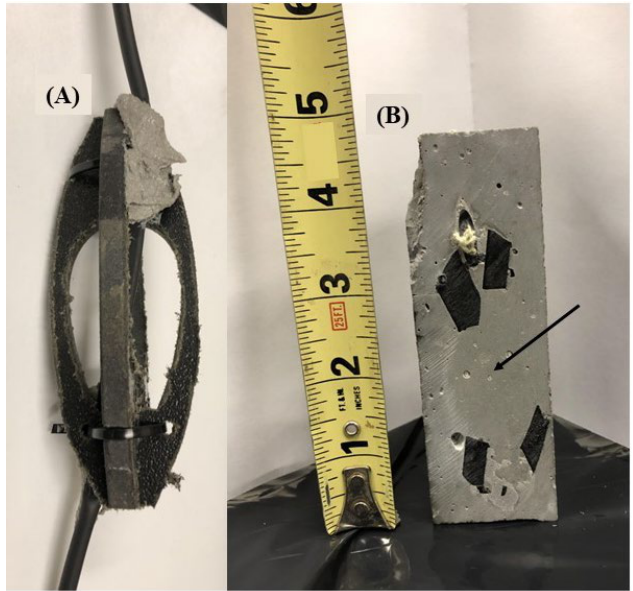
Figure 6. ( A ) The anchoring point attached to the fiber cable at a bonded section using cementitious epoxy resin. ( B ) A cross section of the anchoring point cut from a cement cylinder with an installed anchored fiber. Note the infiltration of grout/cement to the central area of the anchoring point (denoted by black arrow).